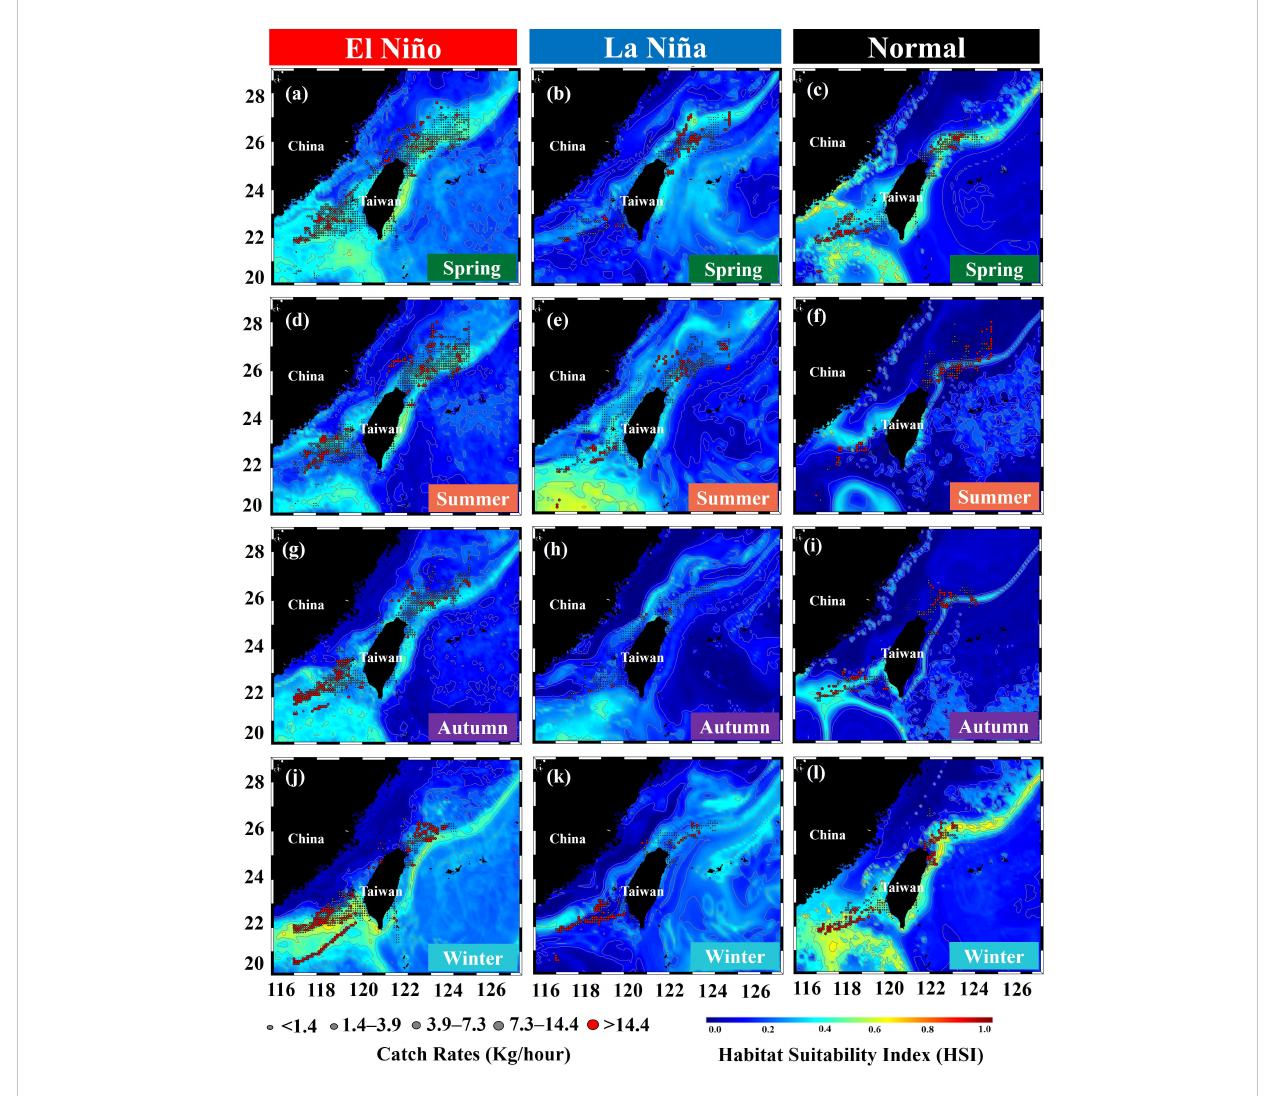
FIGURE 9 Average catch rates of greater amberjack overlaid with habitat suitability in spring (A – C) , summer (D – F) , autumn (G – I) , and winter (J – L) during ENSO